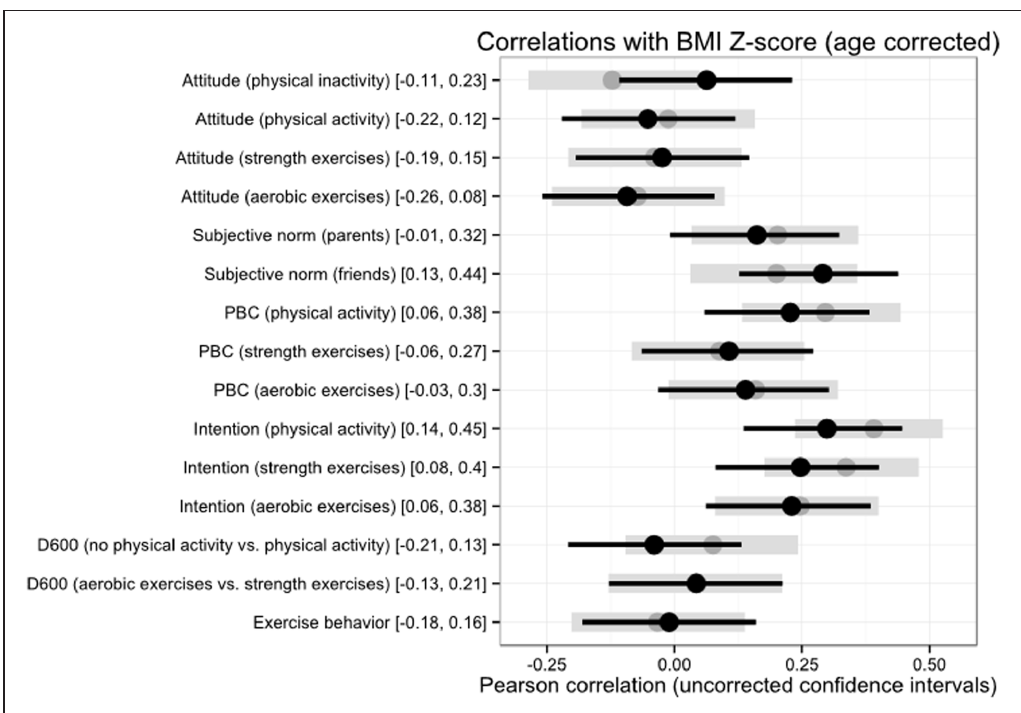
Figure 3: (Age Corrected) Correlations Between the Reflective Determinants and BMI z-scores. The black line represents the confidence intervals for the age corrected correlations; grey lines represent the uncorrected confidence intervals.